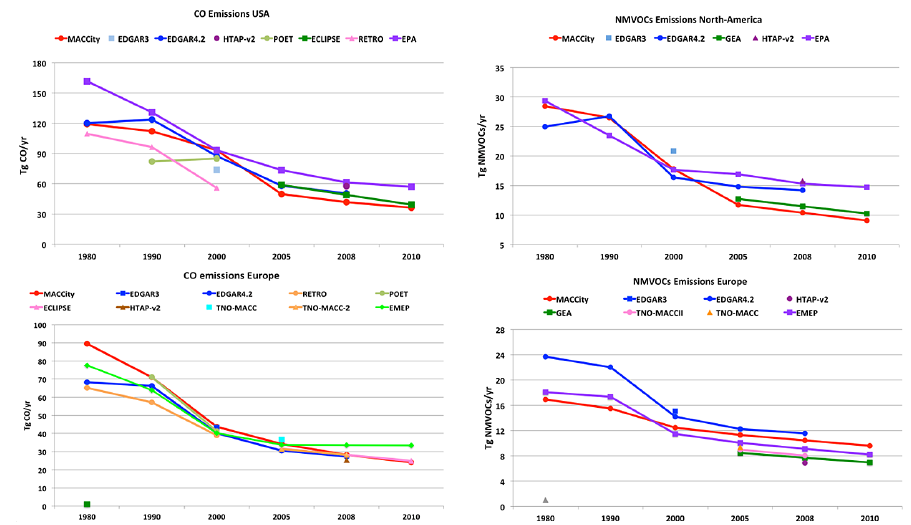
Figure 8. Emissions of CO and NMVOCs in the USA and Europe (western and central Europe) from various emission inventories.